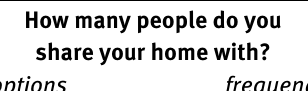
Table 3: Frequency distribution of subjects’ education data